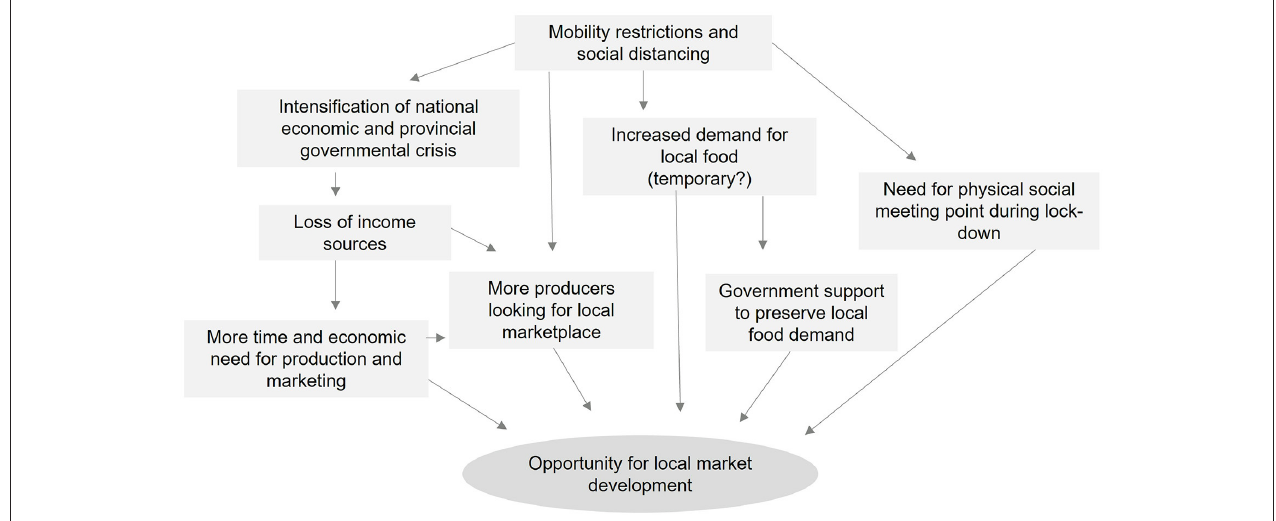
FIGURE 3 | Relational chart of changing conditions for local market development, based on the interview partners’